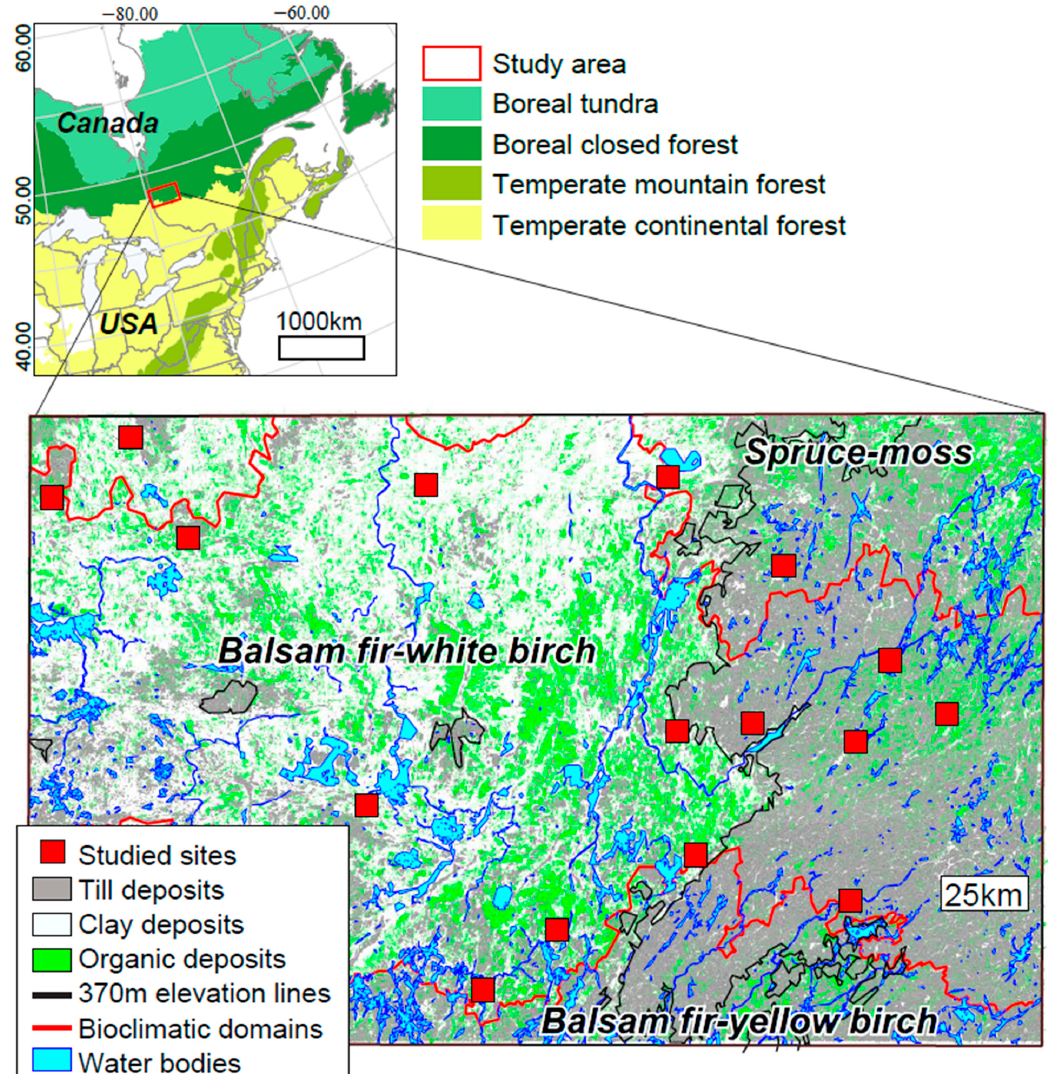
Figure 1. Location of the study area in the southern boreal forest of eastern Canada and location of sampled burned sites (red) within the study area. The red lines show the delimitations between bioclimatic domains. Forest zones in the upper panel were modified from the Food and Agriculture Organization of the United Nations (FAO) Global Ecological Zones (GEZ)